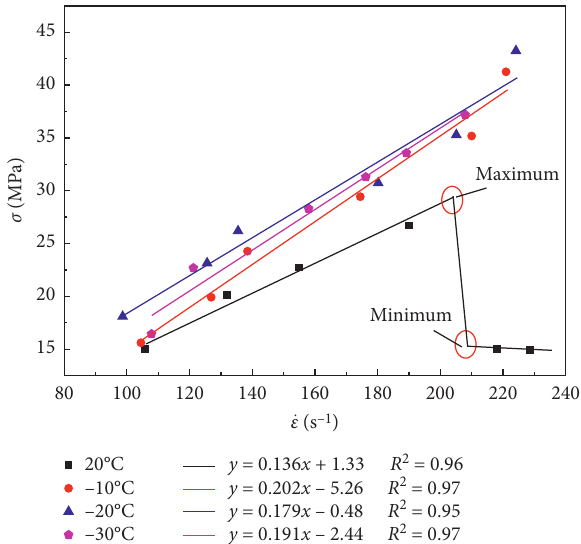
Figure 4: Relationship between peak stress and strain rate of sandstone under different temperatures.